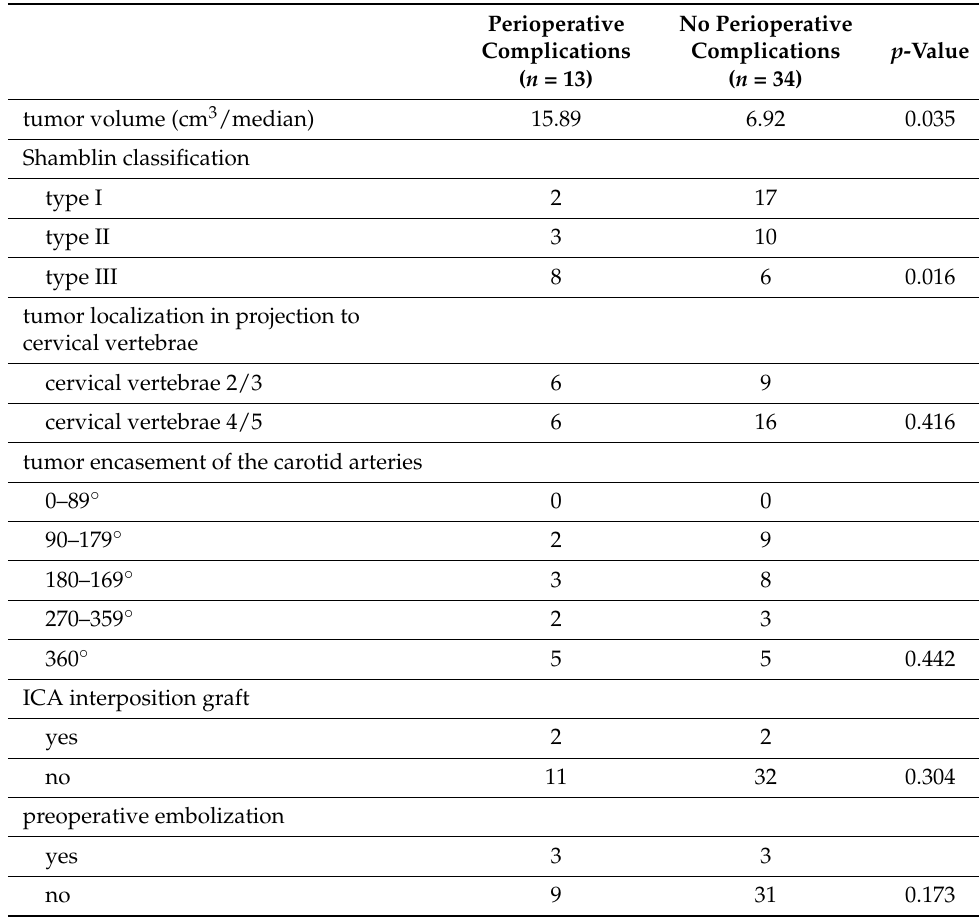
Table 3. Comparison of volumetry and imaging characteristics between patients with and without postoperative complications. ICA: internal carotid artery.